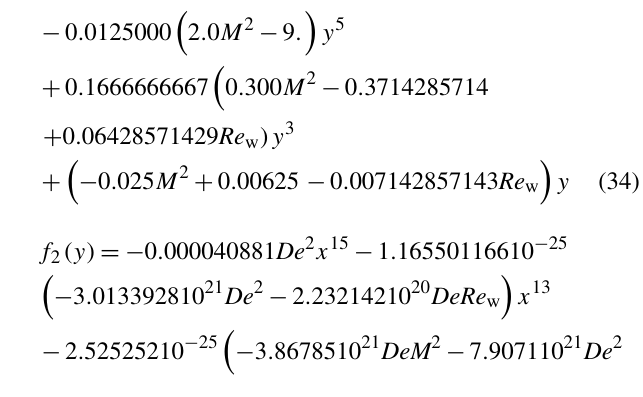
Figure 5. Dimensionless velocities predicted by HAM, HPM and numerical method (NUM) for different Re w number and De at Pr = 1, (cid:125) = − 1 . 5.